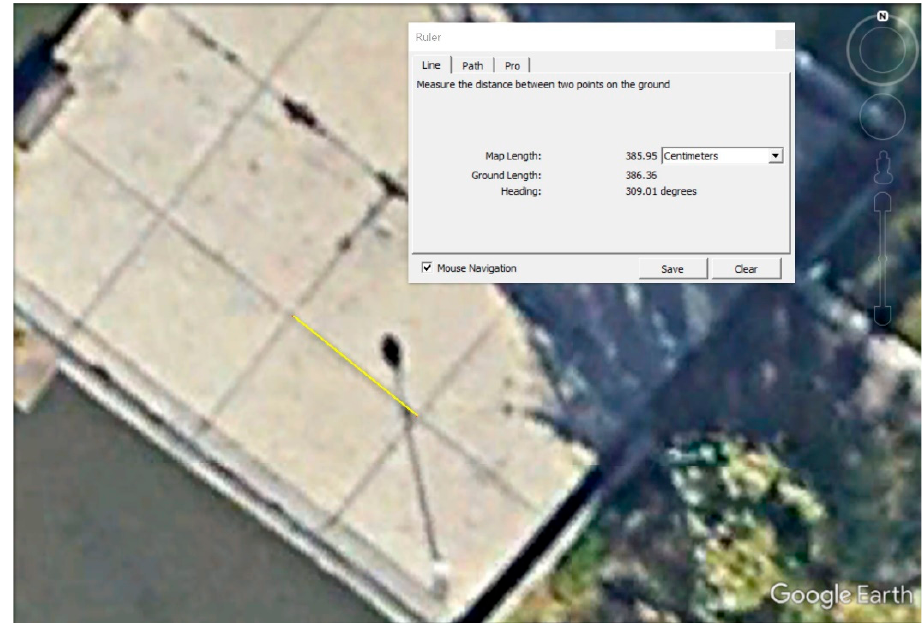
Figure 9. Measure of the distance between points A and B (Figure 8) performed in Google Earth (screenshot).